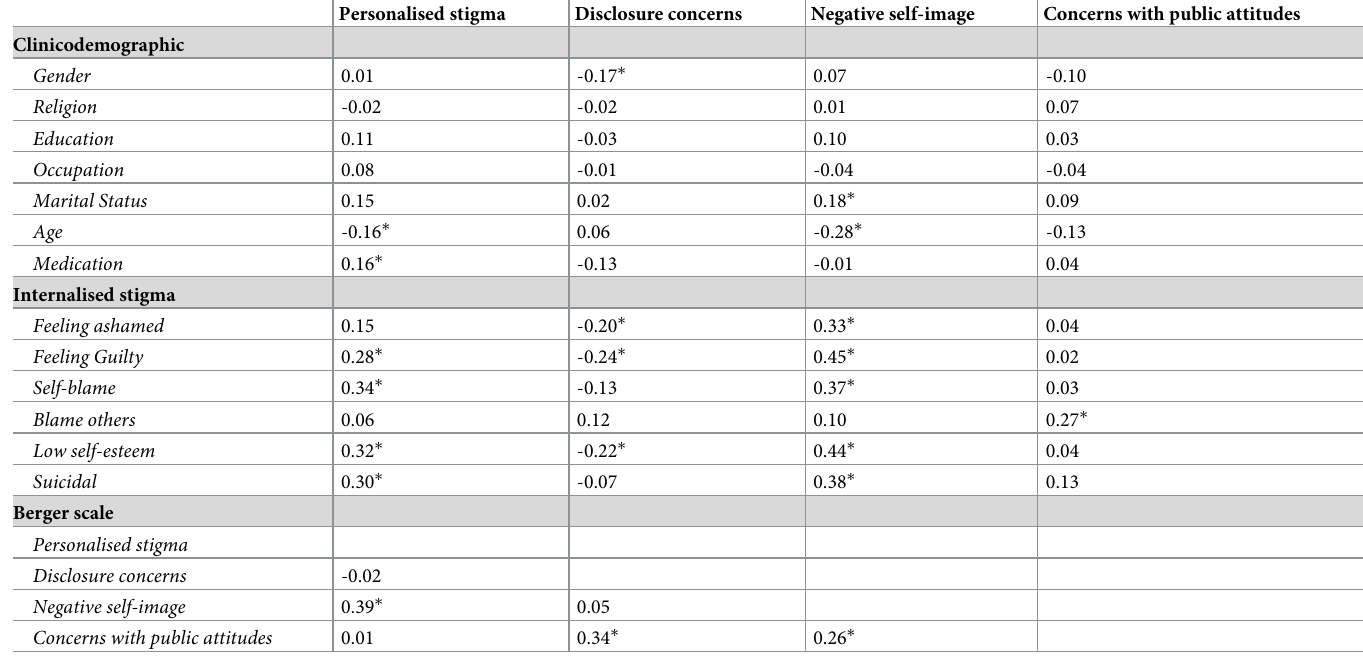
Table 5. Correlations between demographics, internalised stigma and Berger scale (n =